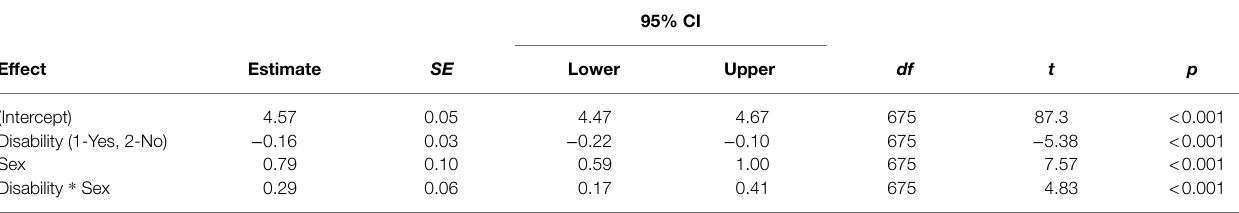
TABLE 1 | Effects for mixed model predicting attractiveness as a function of disability and sex.